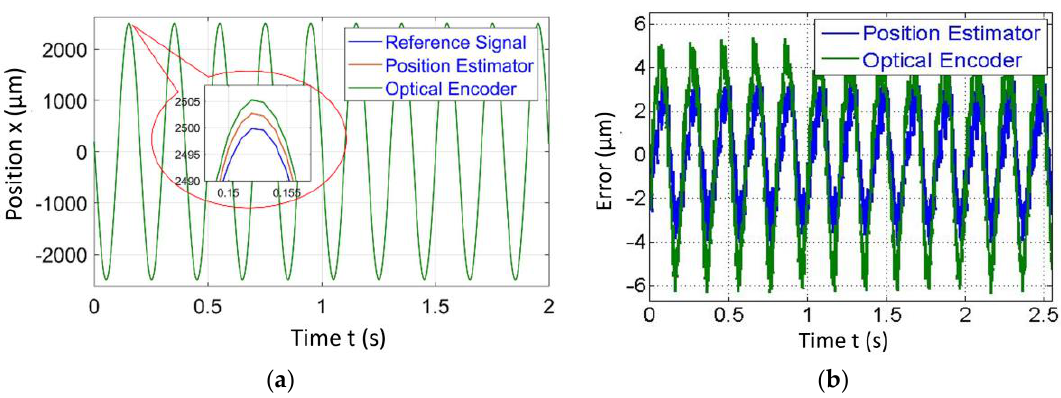
Figure 19. Position estimator output for amplitude = 2500 µm and frequency = 5 Hz at a scanning speed = 50 mm/s.